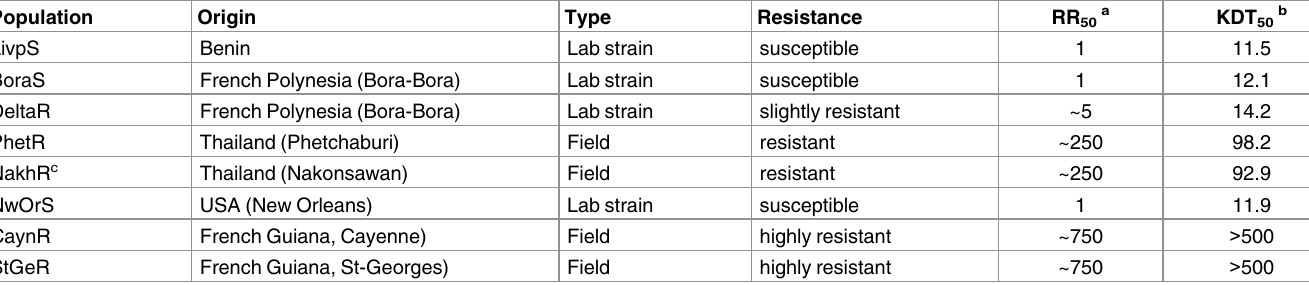
Table 1. Deltamethrin resistance